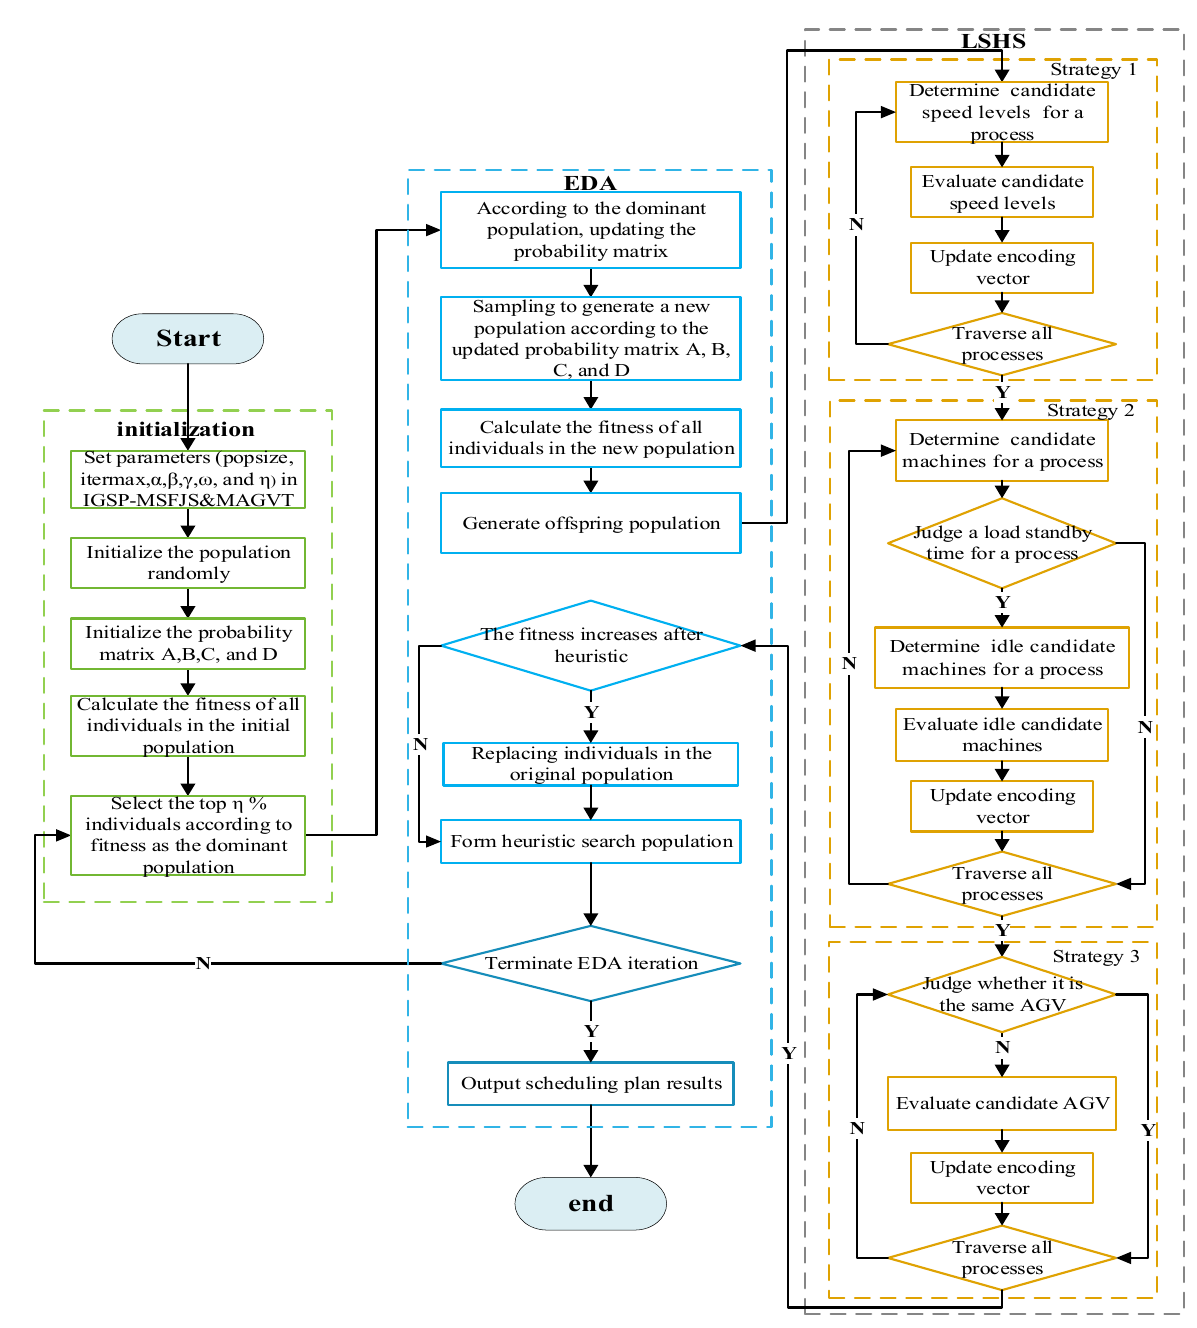
Figure 2. The flowchart of the EDA-LSHS. Step 1: Initialize the population, the EDA-related parameters, and the probability ma- trices. Step 2: Select a dominant population updated probability matrix. Step 3: Generate a new offspring population by sampling based on the updated prob- ability matrix.